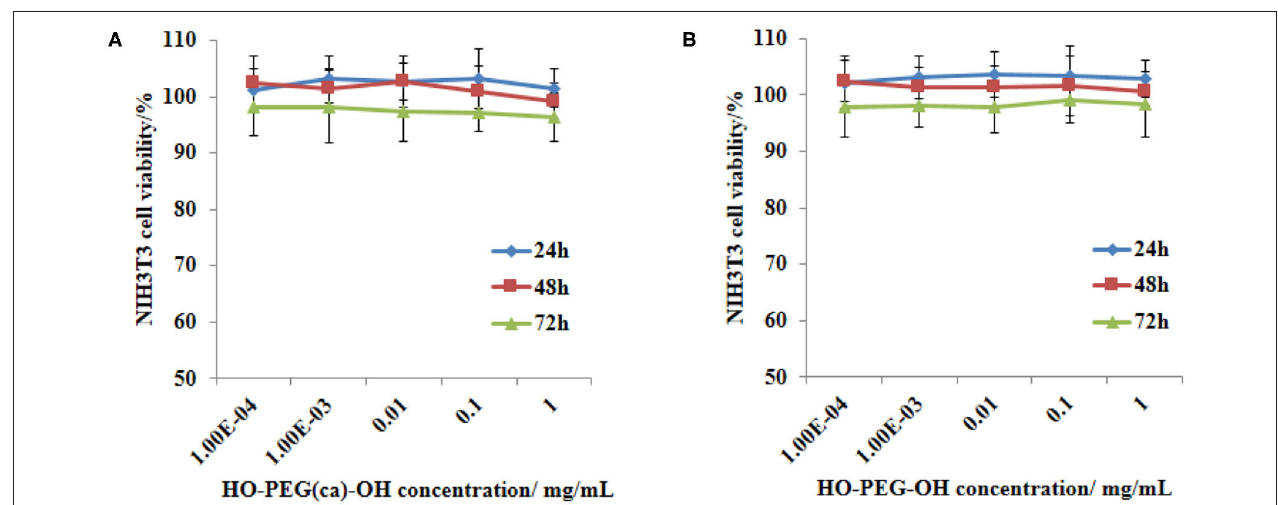
FIGURE 5 | Cell viability data of HO-PEG(ca)-OH and its degradable residue by MTS assay. NIH3T3 cells were subjected to 0.00001, 0.0001, 0.001, 0.01, 0.1, 1 mg/mL of HO-PEG(ca)-OH (M n = 3.88 × 10 3 g/mol) and its degradable residue HO-PEG-OH (M n = 1.90 × 10 3 g/mol) for 24, 48, 72h before undertaking a MTS assay. The results are shown as percent viability compared to the control with media only. Each sample was replicated 6 times.